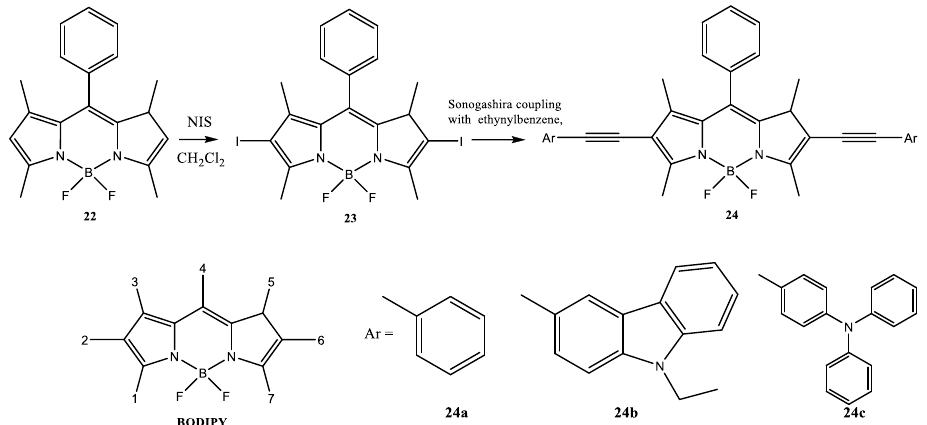
Figure 3. BF 2 -rigidified anilido-pyridine boron difluoride dye.